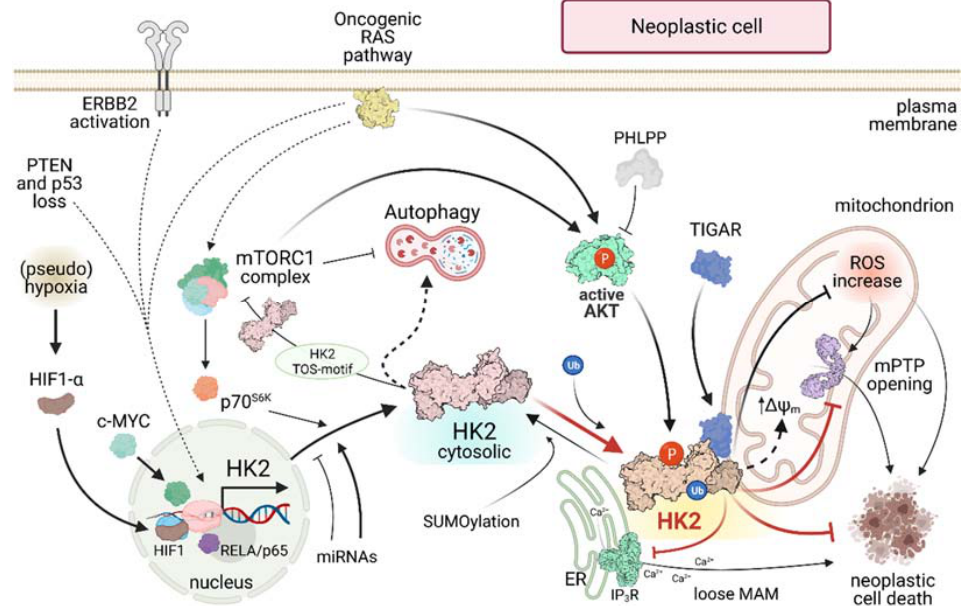
Figure 2. HK2 regulatory pathways in neoplastic cells. Continuous lines indicate direct effects; dashed lines indicate indirect effects. ERBB2: ERB-B2 Receptor Tyrosine Kinase 2; PTEN: Phosphatase and tensin homolog; p53: tumor suppressor p53; HIF: Hypoxia Inducible Factor; RELA/p65: nuclear factor NF-kappa-B p65 subunit; mTORC: mammalian Target Of Rapamycin Complex; p70S6K: p70-S6 Kinase 1; PHLPP: PH domain and Leucine rich repeat Protein Phosphatase; TIGAR: TP53 Induced Glycolysis Regulatory Phosphatase; ROS: Reactive Oxygen Species; ΔΨ m : mitochondrial membrane potential; mPTP: mitochondrial Permeability Transition Pore; ER Endoplasmic Reticulum; IP 3 R: Inositol-3-Phosphate Receptor; MAM: Mitochondria-Associated Membrane; P: Phosphorylation; Ub: Ubiquitination.